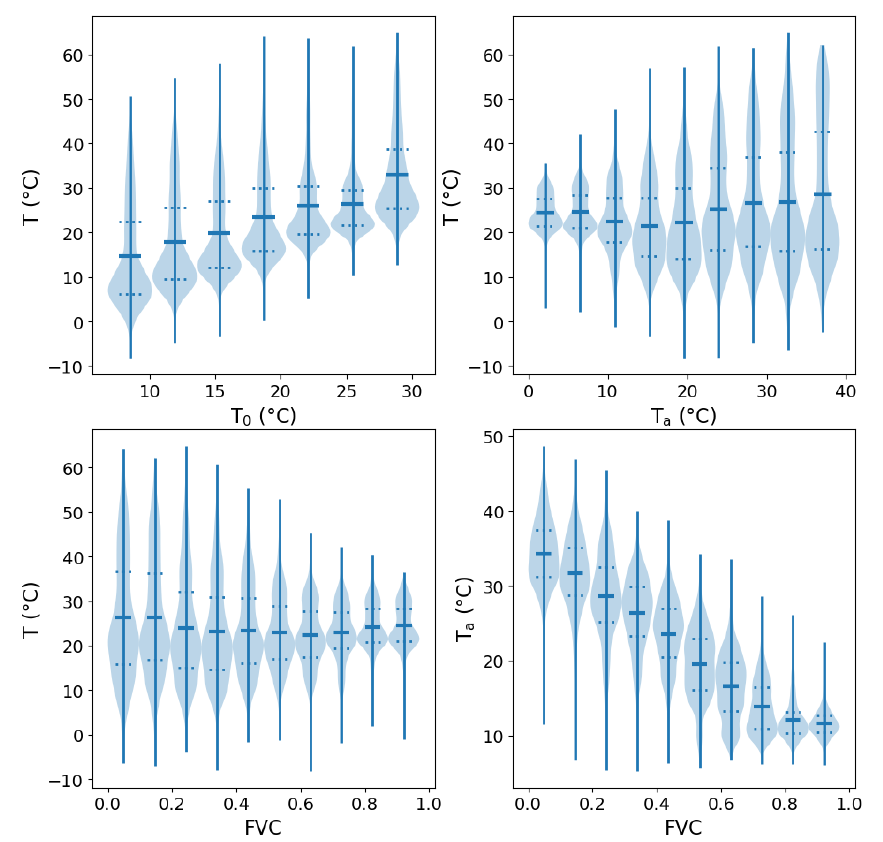
Figure 2. High-resolution surface-temperature T as a function of the high-resolution ancillary vari- ables suggested as predictors for the downscaling. T versus the minimal temperature ( T 0 ) ( top left ), versus the amplitude of the diurnal cycle ( T a ) ( top right ), versus the fractional vegetation cover ( FVC ) ( bottom-left ). T a versus FVC is also shown ( bottom-right ). For each panel the distribution of the y-axis variable for a bin of value for the x-axis variable is shown in the blue shade. Additionally, the mean (solid line), upper and lower quartiles (dotted lines) are indicated, as well as the extrema of the